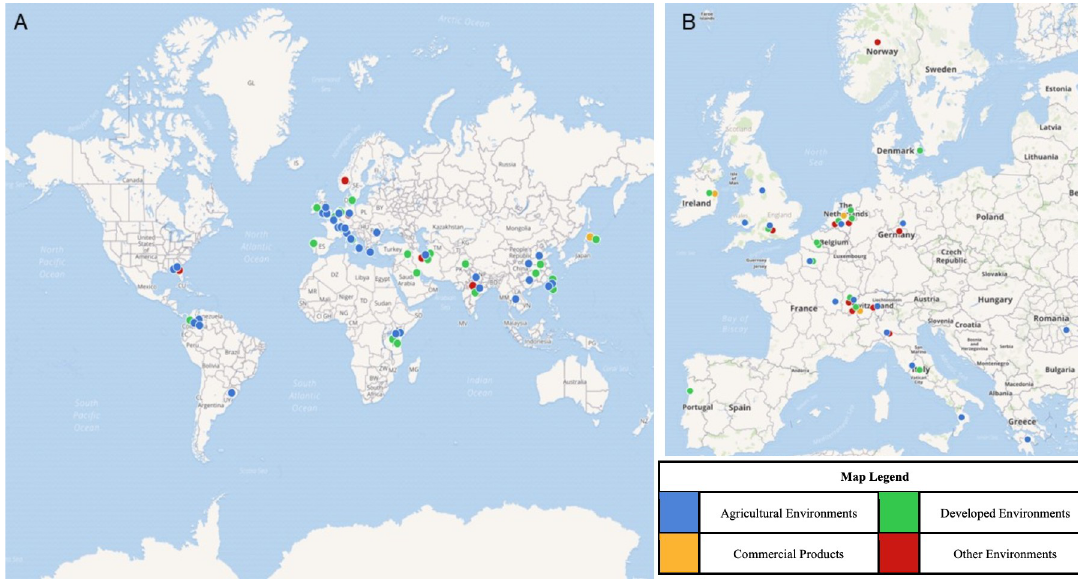
Fig 1. A AU : PleasecheckwhethertheeditstothesentenceAzole (cid:0) resistantAspergillusfumigatusintheenvironment ::: ð Fig 1 caption Þ arecorrect ; andprovidecorrectwordingifnecessary : zole-resistant Aspergillus fumigatus in the environment detected throughout (A) the world and (B) in Europe. The figure legend indicates different environmental settings from which resistant isolates were recovered. The digital map that includes additional environmental data, cyp51A alleles, and links to the published articles for each isolate can be found at https://maphub.net/cburks817/ AfumMap. The base layer of the map can be found at https://maphub.net/map.